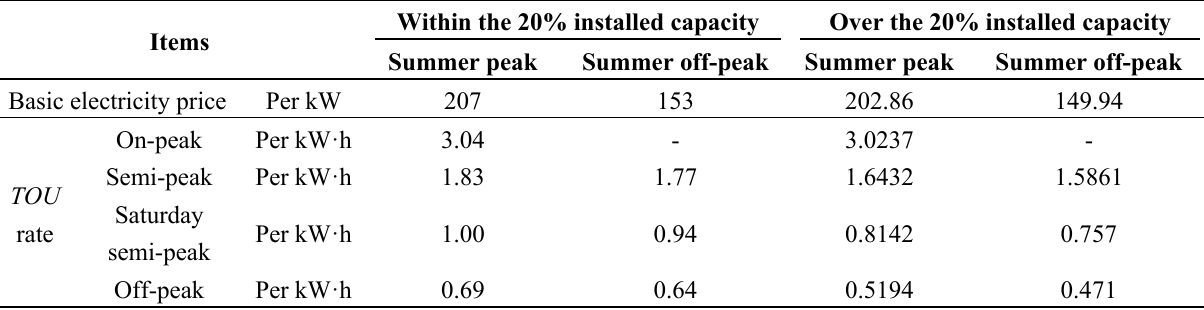
Table 9. Rate of selling electricity back to the utility. Unit: